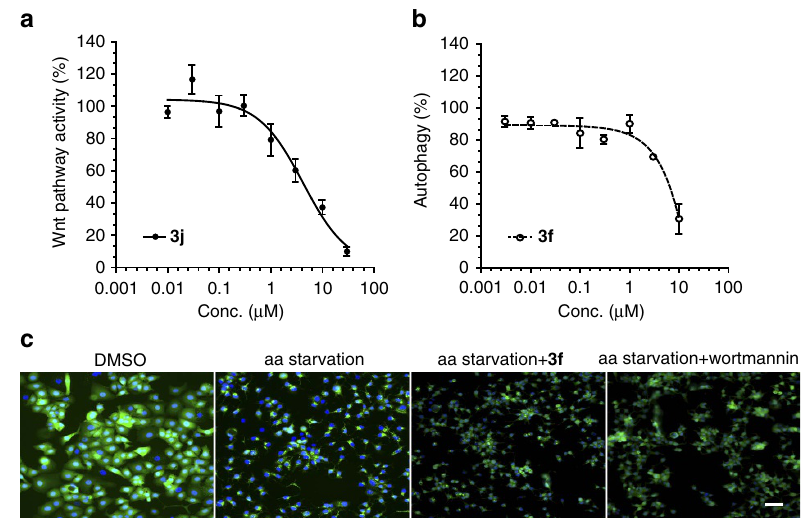
Figure 8 | Influence of representative compounds on Wnt signalling (3j) and autophagy (3f). ( a ) Dose-dependent inhibition of the Wnt pathway as determined by means of Wnt reporter gene. HEK293 cells stably transfected with the human Frizzled-1 receptor and a TOPFLASH-driven luciferase reporter gene were treated with different concentrations of 3j for 6h. Expression of the firefly luciferase as a reporter gene was the determined by means of luminescence as readout. Nonlinear regression analysis was performed using a four parameter fit. Data are mean values of three independent experiments ( n ¼ 3) ± s.d. ( b ) Dose–response curve for inhibition of autophagy by 3f . MCF7-GFP-LC3 cells were deprived of amino acids to induce autophagy and treated with the different concentration of 3f for 3h. GFP-LC3 was detected as a measure of autophagosome formation. Nonlinear regression analysis was performed using a four parameter fit. Data are mean values of three independent experiments ( n ¼ 3) ± s.d. ( c ) MCF7 cells that stably express GFP-LC3 (green) were starved for amino acids (aa) in the presence of the compound 3f (10 m M) or Wortmannin (3 m M) for 3h before fixation and staining of the DNA using Hoechst 33342 (blue). Autophagy induction is detected as an accumulation of GFP-LC3 puncta on starvation. Scale bar, 10 m